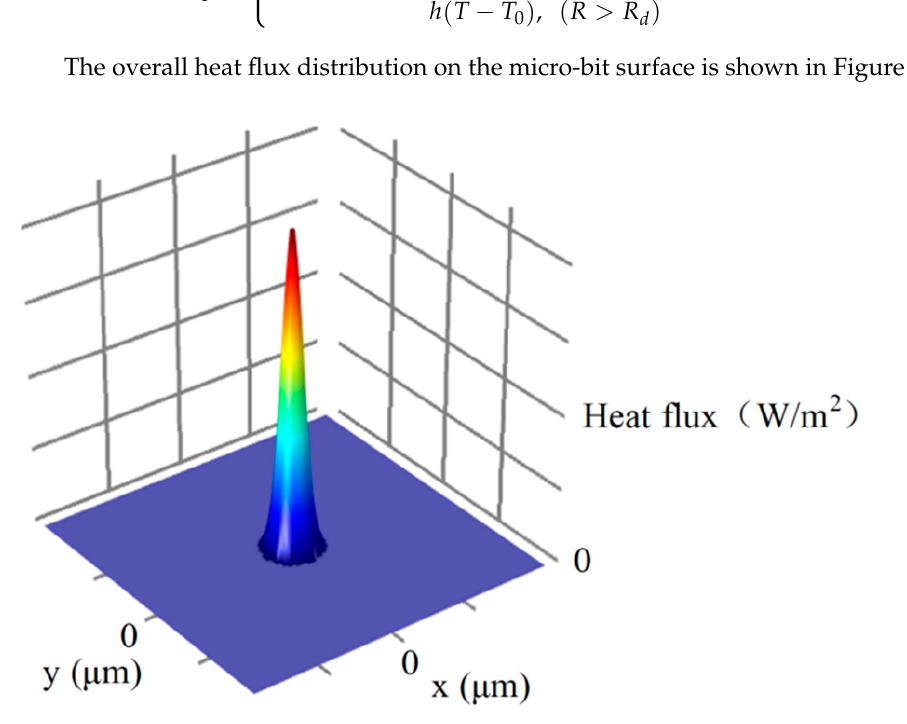
Figure 2. Heat flux density of the micro-bit surface.